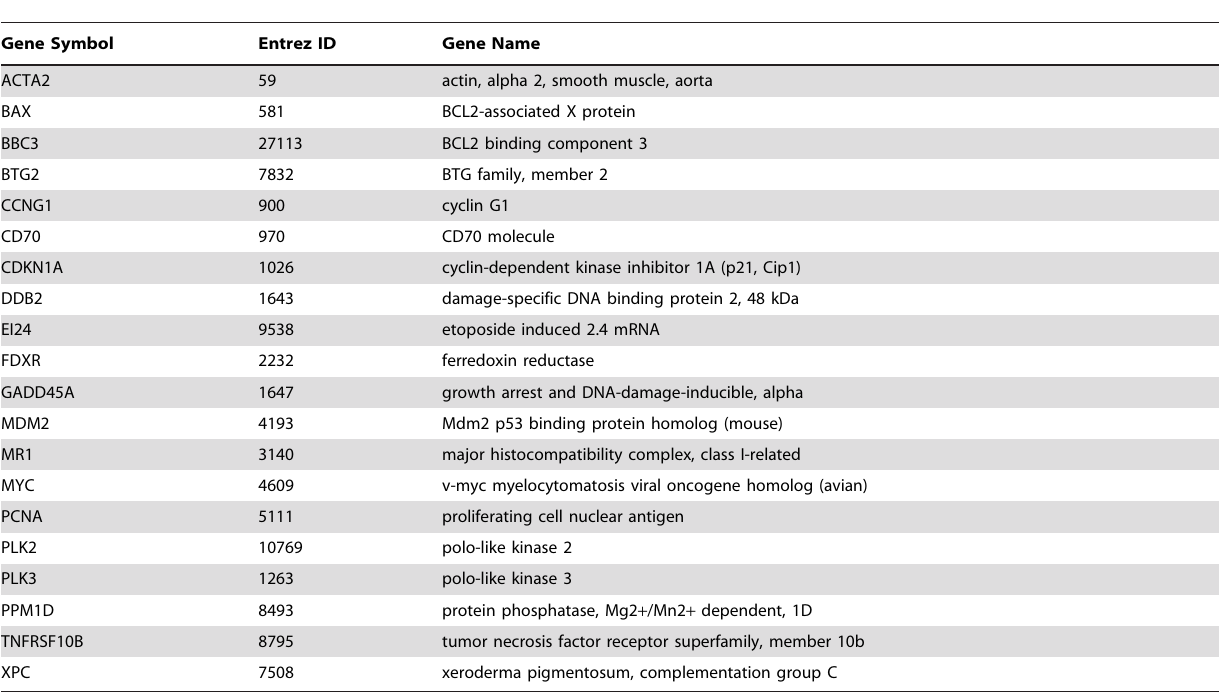
Table 3. Twenty genes commonly identified by literature review and analysis of two microarray datasets.